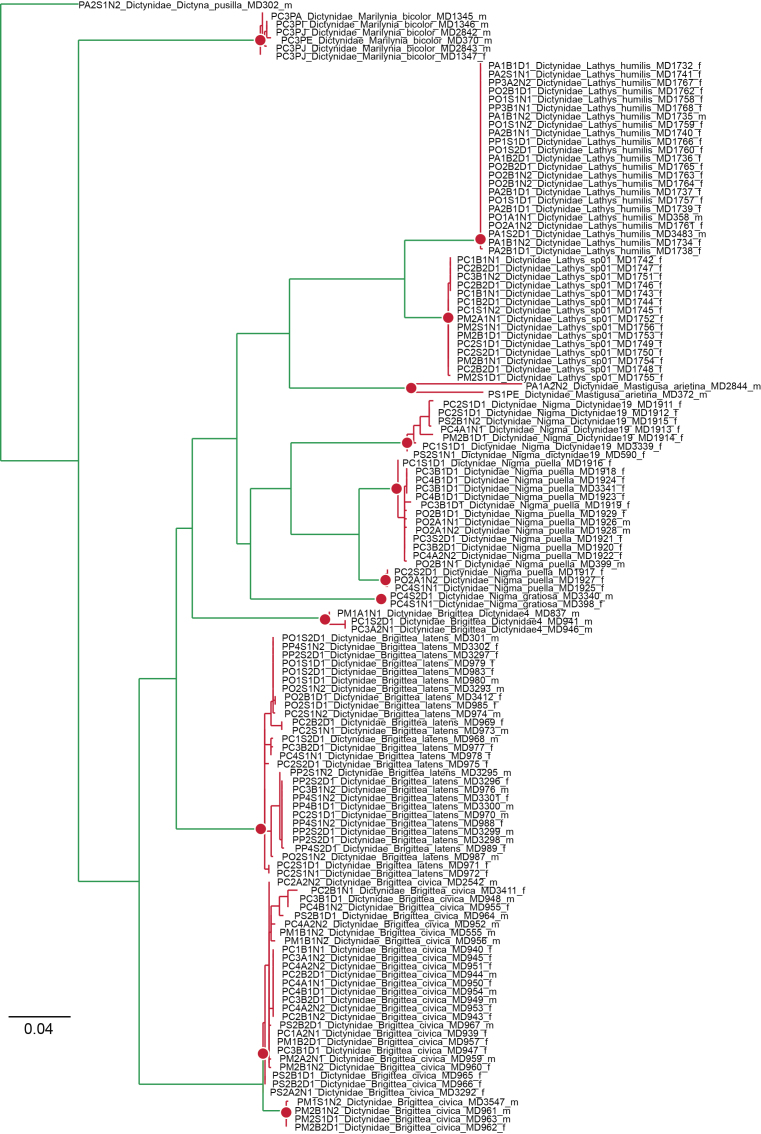
Maximum likelihood tree of the Dictynidae DNA barcode sequences analysed, using a codon partition model with IQ-tree. Red coloured clusters correspond to candidate species as delimited using the mPTP algorithm (see text for details).